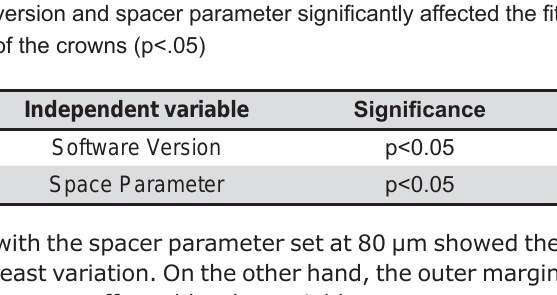
Figure 9- The results of each average values of measuring points categorized as margin (1, 8, a, h), lower axial wall (2, 7, (cid:69)(cid:15)(cid:3)(cid:74)(cid:12)(cid:15)(cid:3)(cid:88)(cid:83)(cid:83)(cid:72)(cid:85)(cid:3)(cid:68)(cid:91)(cid:76)(cid:68)(cid:79)(cid:3)(cid:90)(cid:68)(cid:79)(cid:79)(cid:3)(cid:11)(cid:22)(cid:15)(cid:3)(cid:25)(cid:15)(cid:3)(cid:70)(cid:15)(cid:3)(cid:73)(cid:12)(cid:3)(cid:68)(cid:81)(cid:71)(cid:3)(cid:82)(cid:70)(cid:70)(cid:79)(cid:88)(cid:86)(cid:68)(cid:79)(cid:3)(cid:86)(cid:88)(cid:73)(cid:68)(cid:70)(cid:72)(cid:3)(cid:11)(cid:23)(cid:15)(cid:3)(cid:24)(cid:15)(cid:3)(cid:71)(cid:15)(cid:3)(cid:72)(cid:12)(cid:17)(cid:3)(cid:13)(cid:76)(cid:81)(cid:71)(cid:76)(cid:70)(cid:68)(cid:87)(cid:72)(cid:86)(cid:3)(cid:86)(cid:87)(cid:68)(cid:87)(cid:76)(cid:86)(cid:87)(cid:76)(cid:70)(cid:68)(cid:79)(cid:79)(cid:92)(cid:3)(cid:86)(cid:76)(cid:74)(cid:81)(cid:76)(cid:191)(cid:70)(cid:68)(cid:81)(cid:87)(cid:3)(cid:71)(cid:76)(cid:73)(cid:73)(cid:72)(cid:85)(cid:72)(cid:81)(cid:70)(cid:72)(cid:86) Table 1- Two-way ANOVA analysis showing that